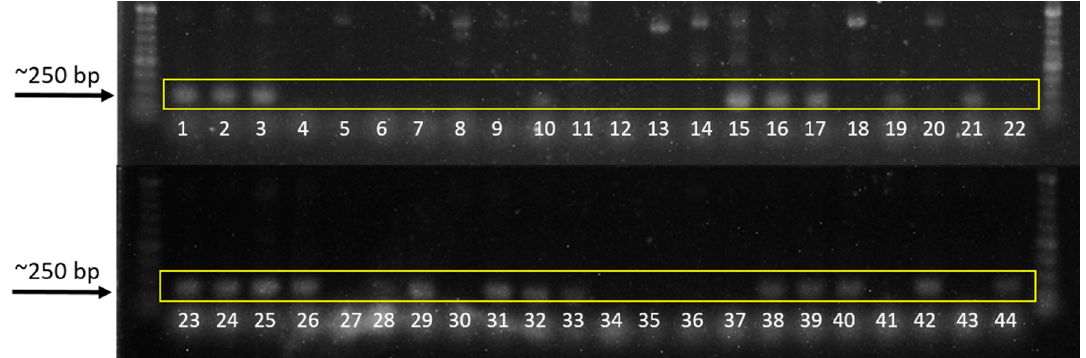
Figure 6. Gel documentation of the resolved DNA products using the specific primers for R. solani AG1-IA. Isolates belonging to subgroup AG1-IA are expected to produce a band of ~265 bp. Test cultures of AG1-IA (lane 21) and AG1-IG (lane 22) were used as positive and negative checks, respectively. Suspected R. solani isolates produced a band size of ~250 bp (lanes 1–3, 10, 15–17, 19, 21, 23–26, 28–29, 31–33, 38–40, 42, and 44). The suspected R. oryzae-sativae isolates (lanes 4–6, 14, 18, 20, 27, 30, 34–37, 41, and 43) and R. oryzae (lanes 7–9) did not produce 250-bp bands. Mungbean isolates BIG and NCPC (lanes 12 and 13) did not produce 250-bp bands.